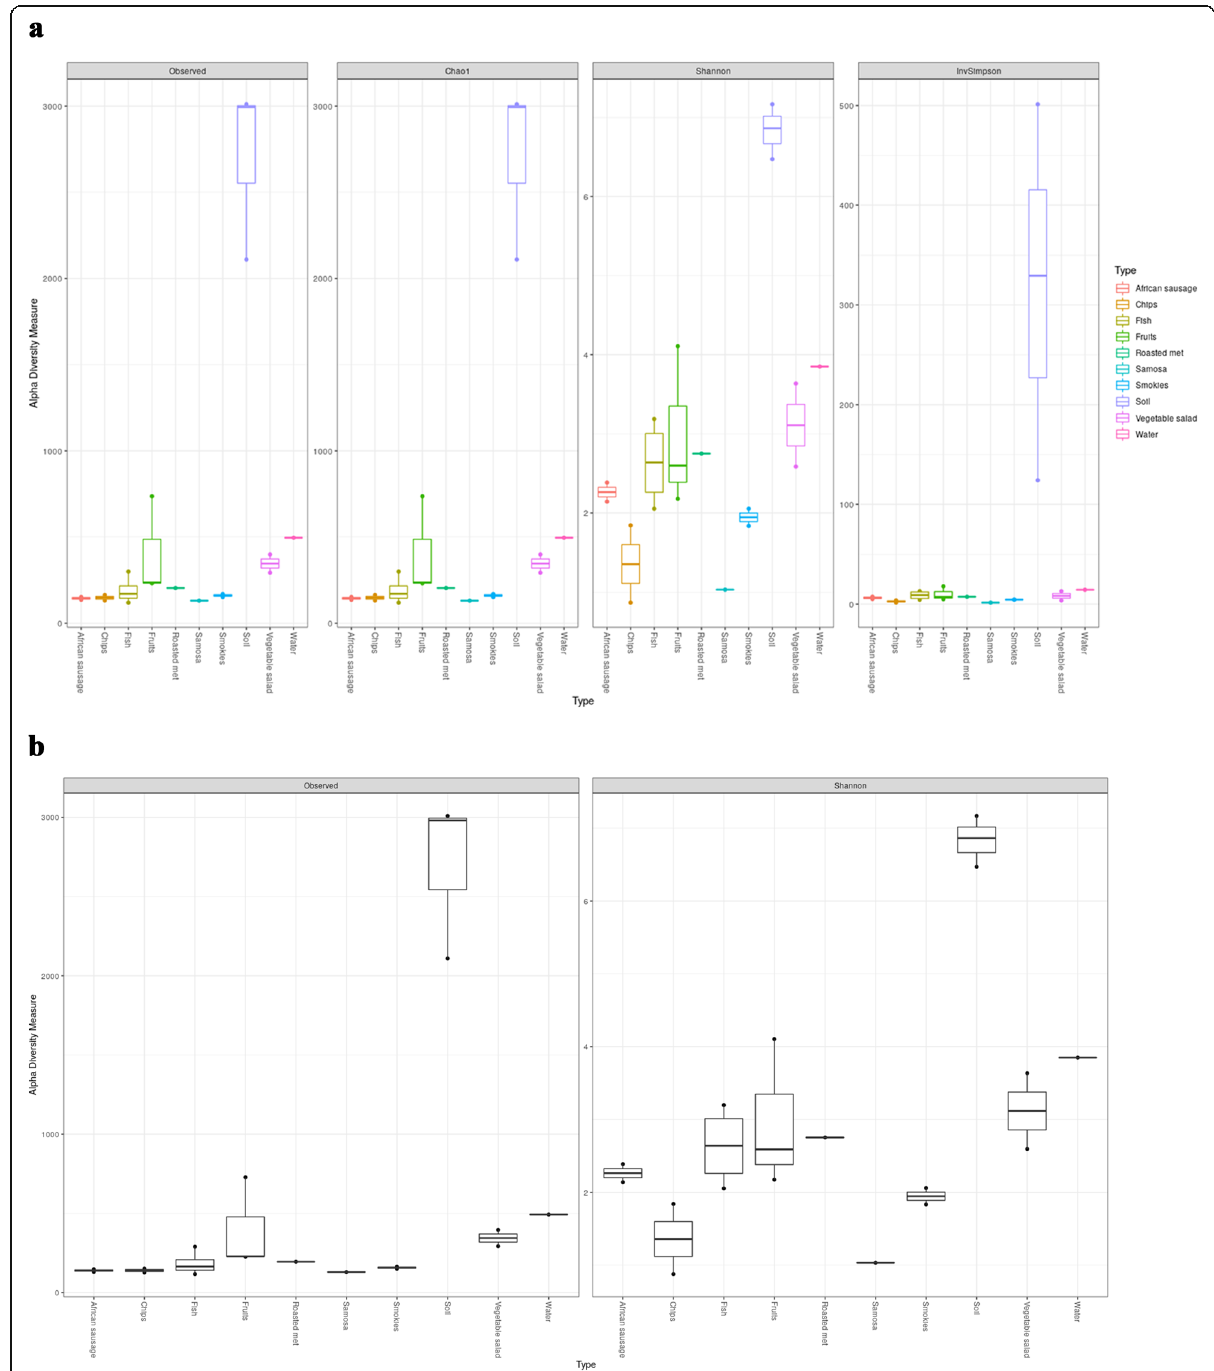
Fig. 6 a Alpha diversity of prokaryotes in vended food and environmental samples from Embu Town and Kangaru Market. b Alpha diversity, measured by the observed taxa and Shannon diversity Index for food and environmental samples from Kangaru Market and Embu